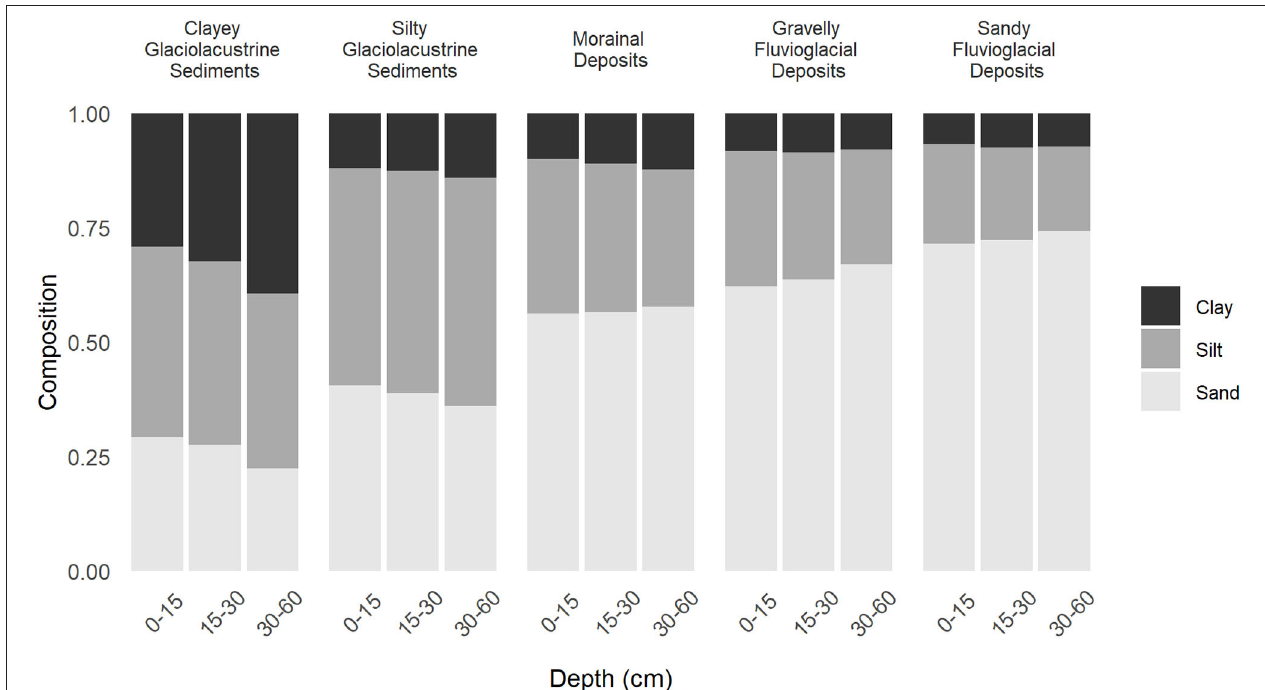
FIGURE 2 | Soil texture composition of all 537 samples separated by the five soil groups used in this study. Soil groups are defined by their surficial deposit classifications. Modified from Midwood et al. (19).